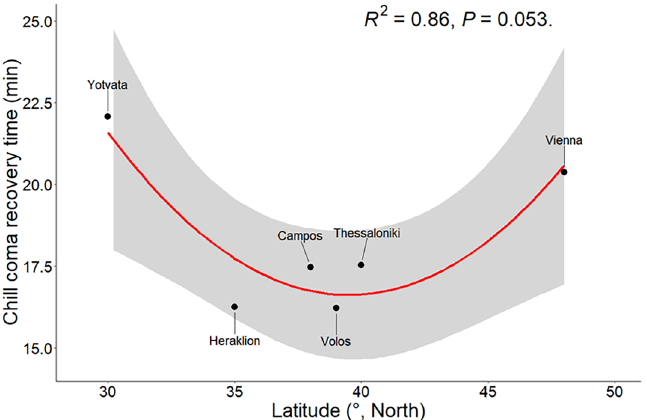
Figure 4. Latitudinal patterns in chill coma recovery time of Ceratitis capitata males and females from the six populations from the Northern Hemisphere. Points represent the mean CCRT for each population. There is a significant curvilinear relationship between chill tolerance and latitude (R 2 = 0.86, p = 0.053, y = 102−4.35x + 0.055x 2 ).